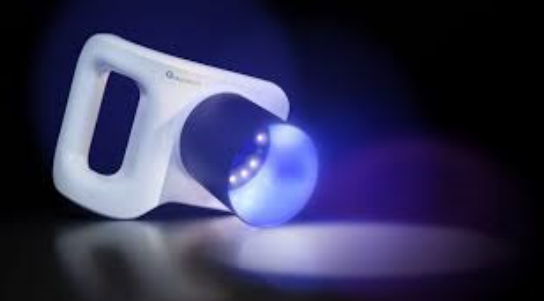
Figure 2. QLF device (Qraycam Pro, AIOBIO, Seoul, Republic of Korea).